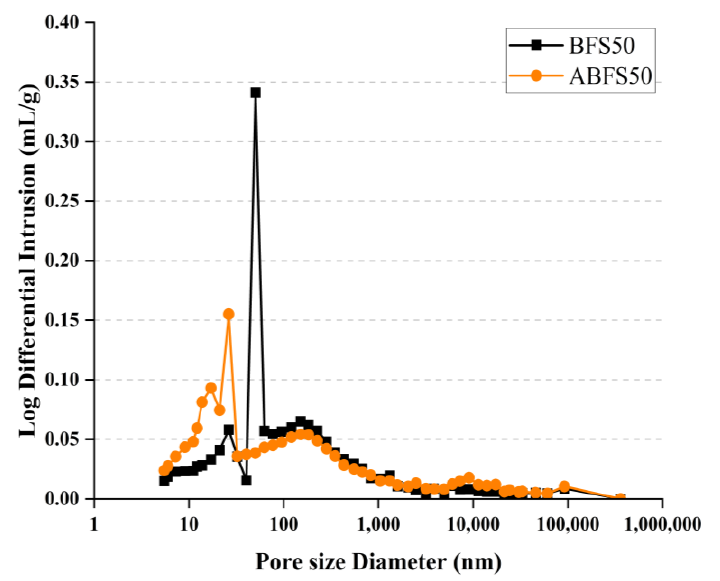
Figure 16. MIP results for BFS50 and ABFS50.